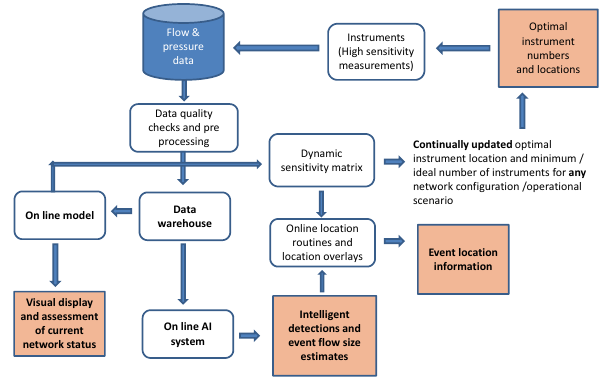
Figure 6. Schematic of idealised combined